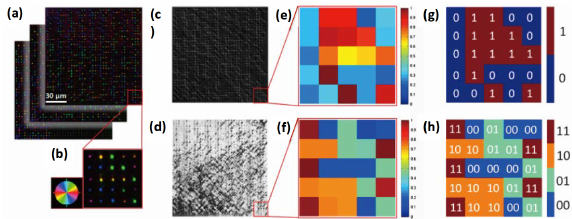
Figure 11: Five-dimensional data storage readout. (a) Birefringence measurement of the data recorded in three different layers in depth. (b) Enlarged 5 × 5 dots array. (c) Retardance distribution retrieved from the top data layer. (d) Slow axis distribution retrieved from the top data layer. (e,f) Enlarged normalized retardance matrix and slow axis matrix from (b). (g,h) Final binary data retrieved from (e) and (f) [95]. Reproduced with permission from American Physical Society, © 2008 by American Physical Society.